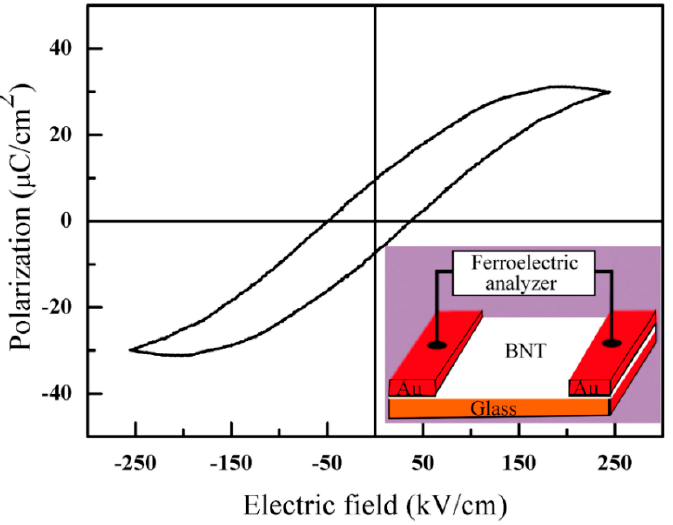
Figure 4. The ferroelectric hysteresis loop of BNT. The inset is the schematic diagram for the ferro- electric measurement.